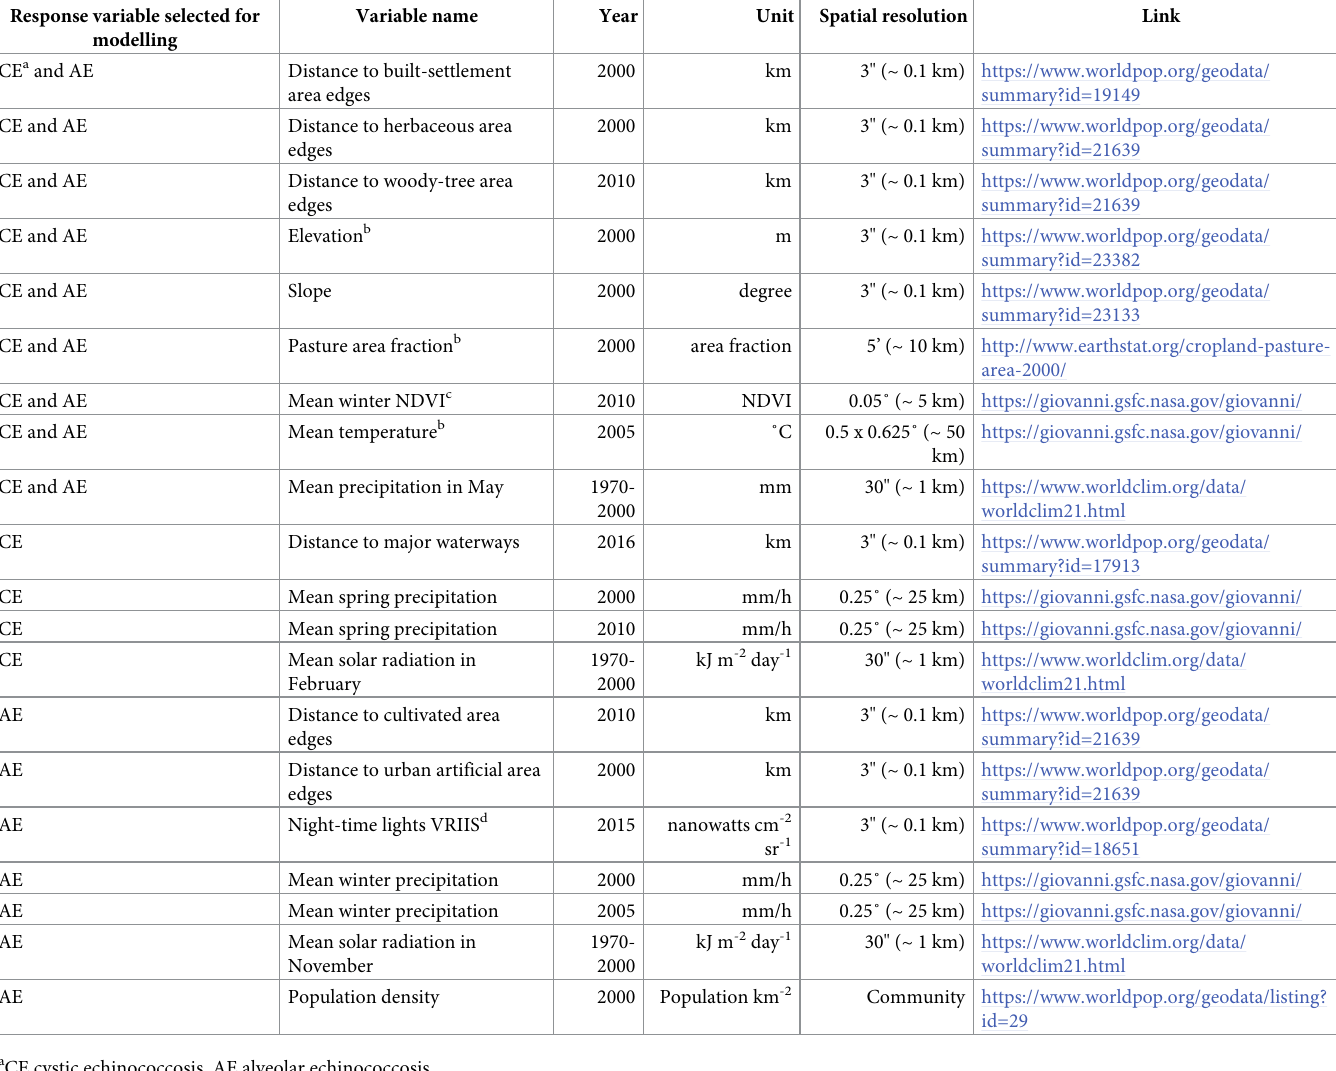
proportion of pasture, and 10-year lag mean annual temperature) for CE and 2 explanatory variables (i.e., elevation and 10-year lag mean annual temperature) for AE. Based on DIC val- ues, one variable was removed from AE CAR models. For CE 13 and for AE 16 explanatory variables were selected to fit CAR models (Table 1). For each selected explanatory variable, a descriptive report including, an overview (name and description), metadata (data type, year, unit of measure, spatial resolution, source), summary statistics (mean, standard deviation and range), and a choropleth map with pop-up windows for each community with its relative rounded value is available here: https://www.math.uzh.ch/pages/kgz_eco/. Table 1. Selected explanatory variables used in this study in the spatial models for cystic echinococcosis and alveolar echinococcosis in Kyrgyzstan, 2014-2016. Response variable selected for